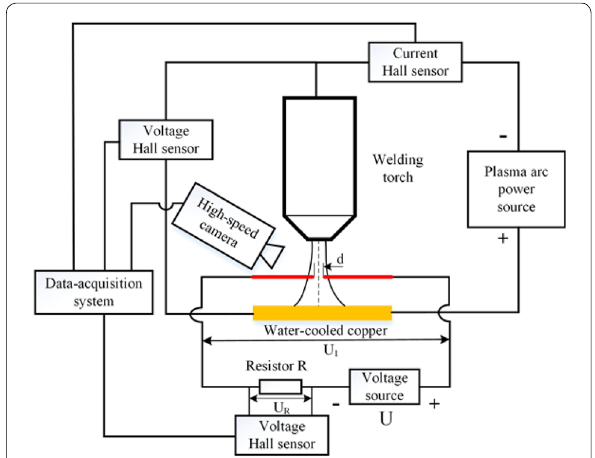
Figure 3 Schematic diagram of the experimental